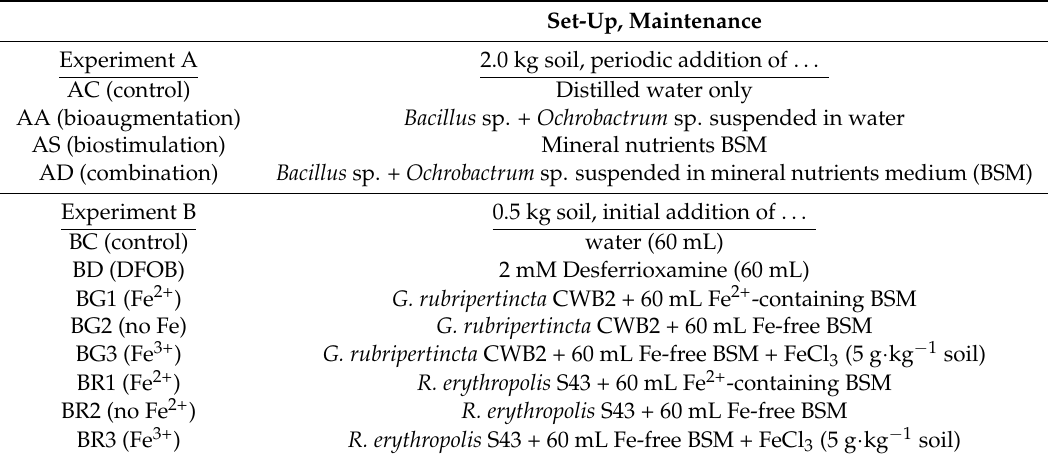
Table 2. Description of experimental